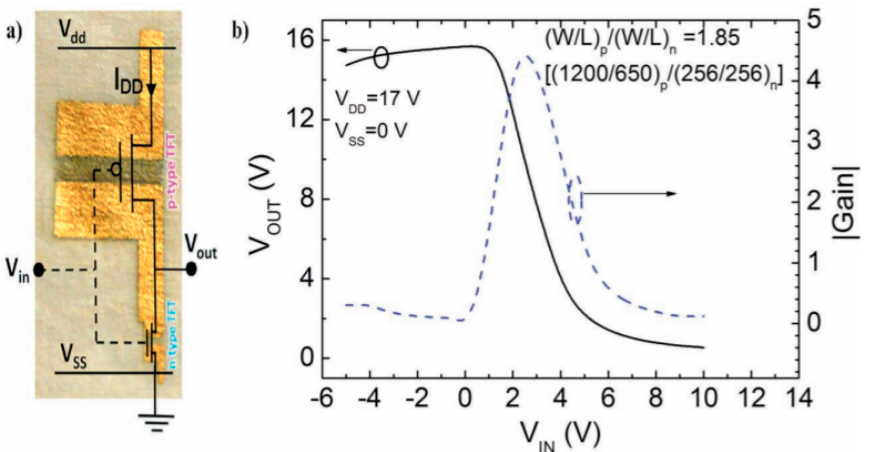
Figure 29. ( a ) Picture of a paper CMOS inverter with a p-FET of W/L = 22 a n-FET of W/L = 12. ( b ) Electrical characteristics of the inverter. Reproduced from [46] with permission. Copyright © 2012 Wiley and Sons.